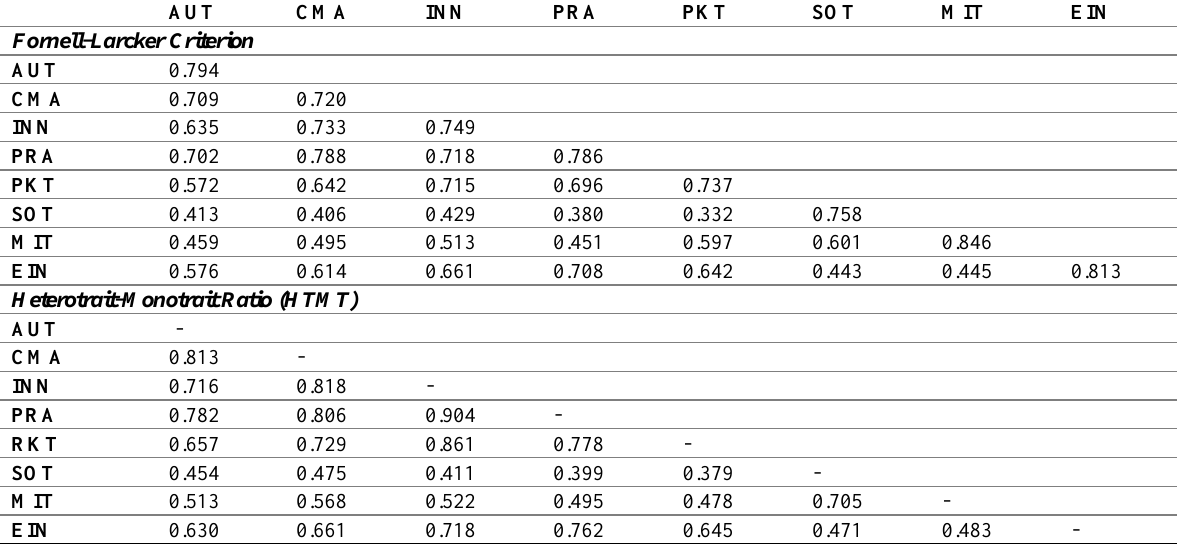
Table 3: Construct level discriminate validities (Stage